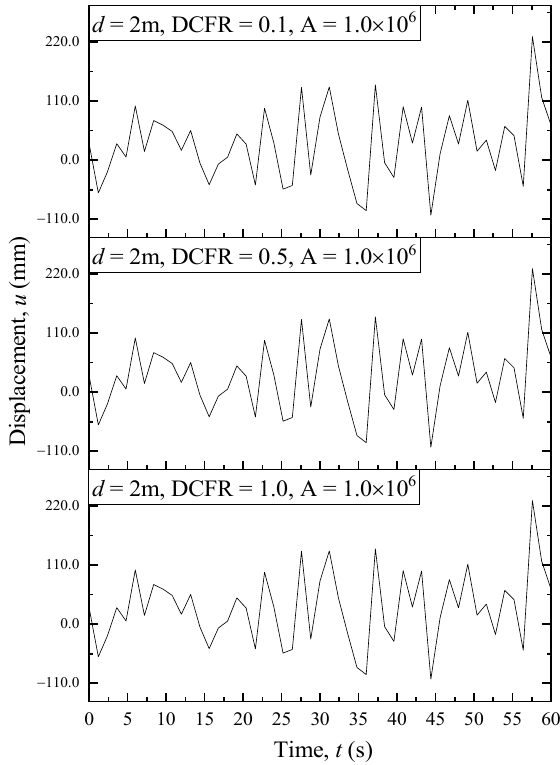
Figure 4. Sensitivity analysis of DCFR.